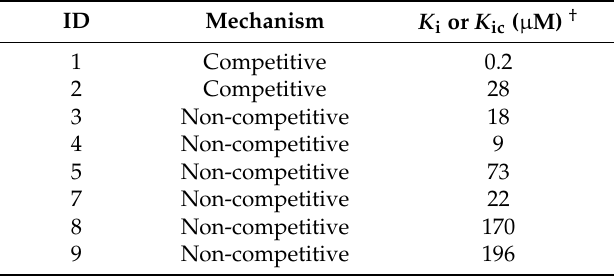
Table 2. The inhibitory mechanisms and constants from enzyme kinetics with inhibitors.